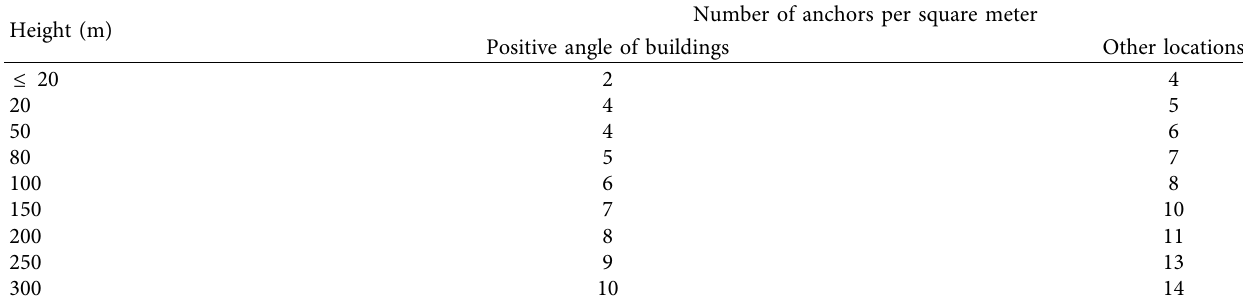
Table 8: The number of anchor